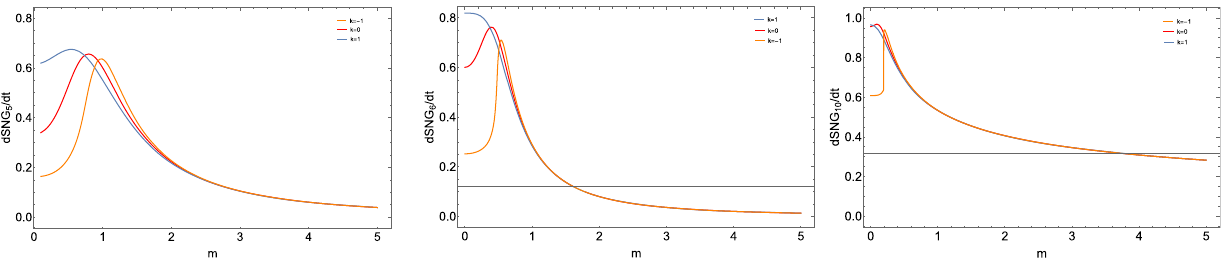
Fig. 10 Action growth v.s. string velocity in massive AdS black hole with m = 0 . 5. From left to right, the dimension is 5 , 6 and 10. In all cases, we have set the black hole mass m 0 = 2